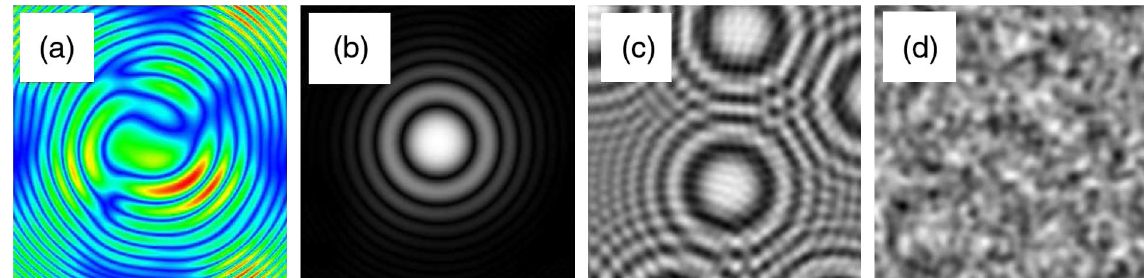
FIG. 2. Fundamentals of the heterodyne near field speckle technique. Simulation parameters are λ ¼ 440 nm and z ¼ 2 mm. A 2-D Gaussian coherence factor of the form exp ð − ½ x 2 þ y 2 (cid:3) = σ 2 Þ has been used, with σ coh ¼ 60 μ m. (a) Time-resolved interference fringes coh generated by the superposition of the spherical wave scattered by one colloidal particle and the transmitted partially coherent SR wavefront. (b) Time-integrated single-particle interferogram. (c) Sum of N ¼ 10 heterodyne interferograms: interference fringes are still visible and may allow coherence measurements through their visibility. (d) Speckle field from N ¼ 10000 colloidal particles: interference fringes are no more visible but coherence properties are still retrievable in Fourier